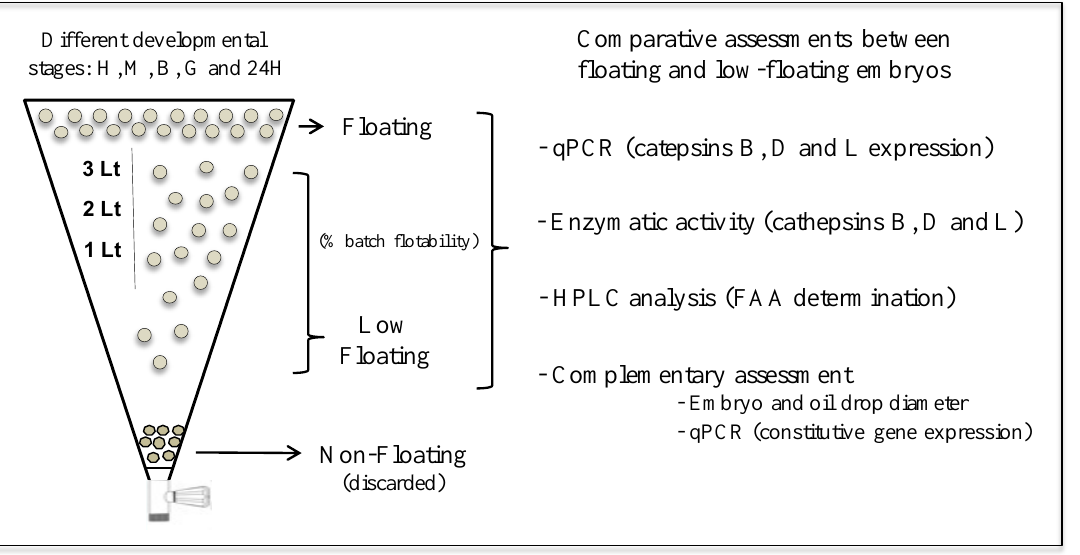
Figure 1. Experimental design. The developmental stages H, M, B, G and 24H correspond to fertilized eggs, morula, blastula, gastrula, and 24 h post fertilization embryos, respectively.